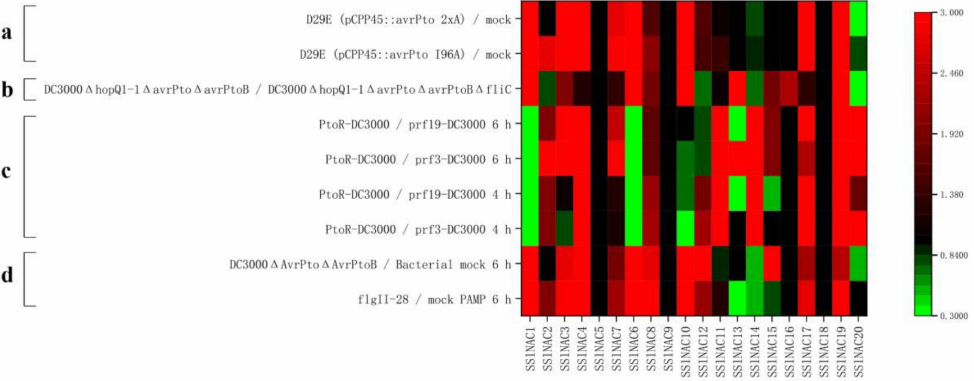
Figure 5. The heat map represents the expression of 20 SSlNAC genes in response to Pst DC3000 with different treatments. ( a , c , d ) Expression profiles of 20 SSlNAC genes under Pst DC3000 mutant strains. ( b ) Expression profiles of 20 SSlNAC genes in resistant and susceptible tomato under Pst DC3000